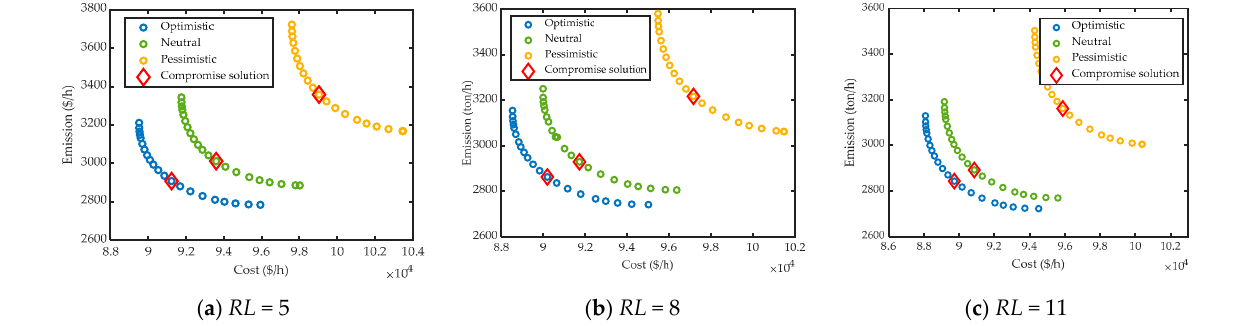
Figure 6. Convergence characteristics for case 3.